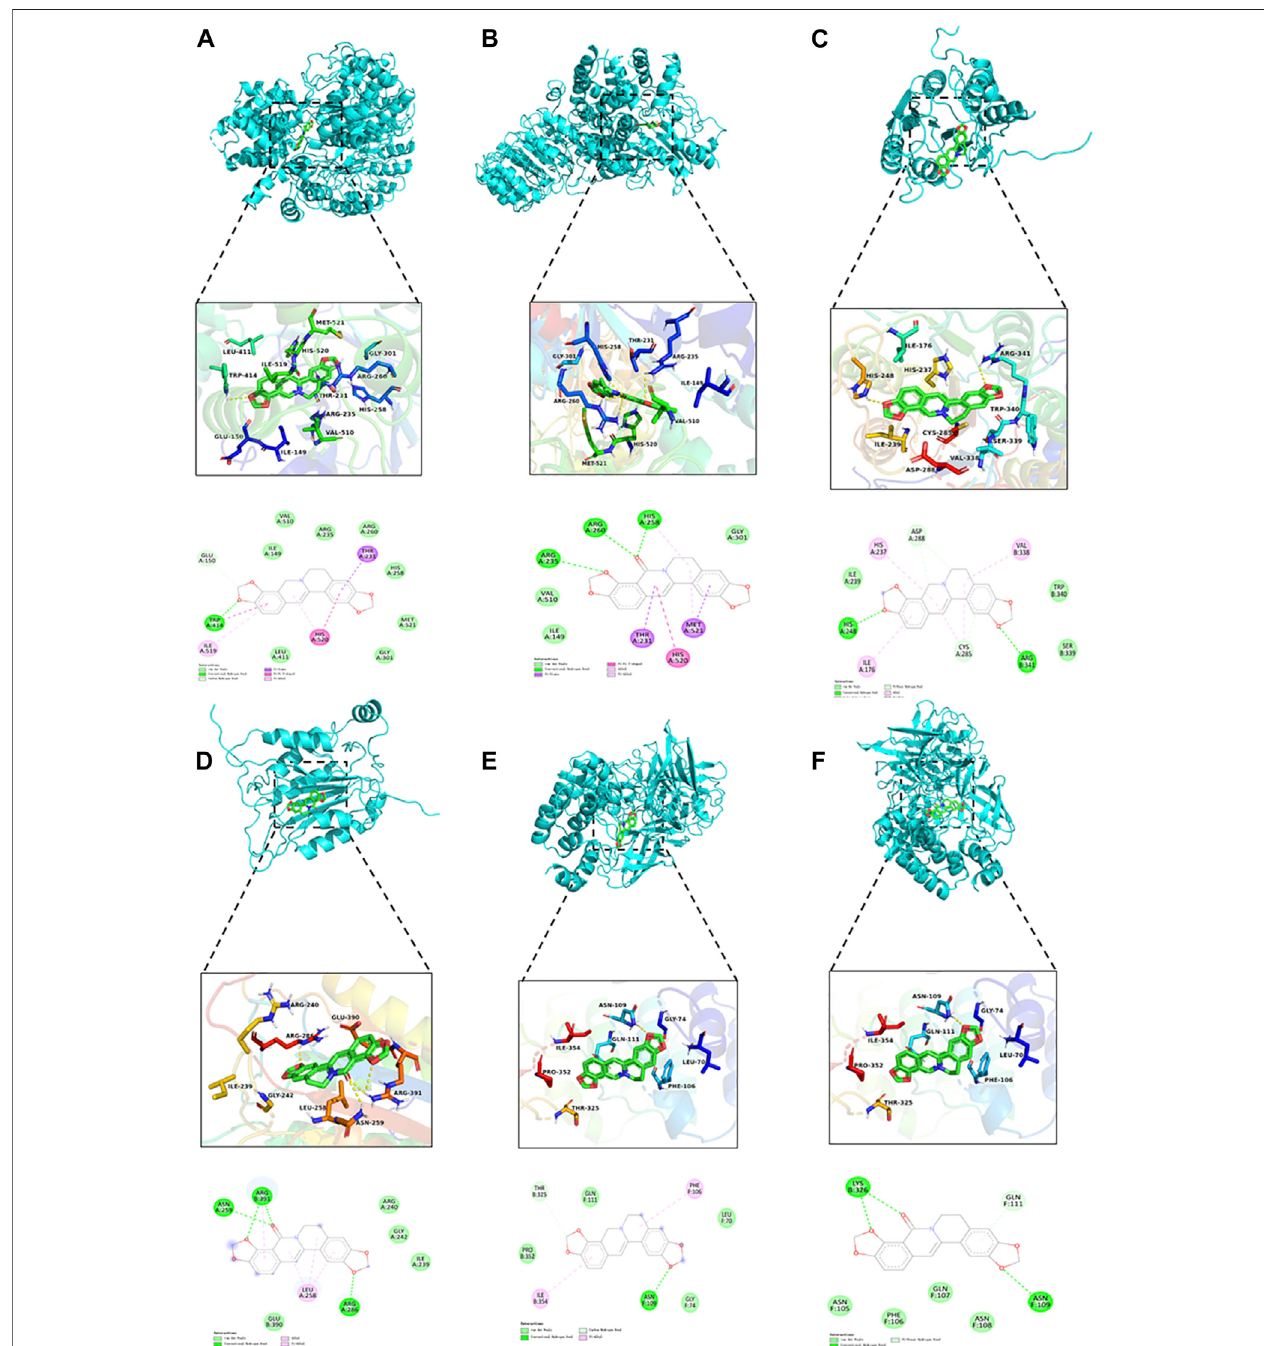
FIGURE10| MoleculardockingsimulationofCOPintotheactivesiteofNLRP3 (A) .OCOPintheactivesiteofNLRP3 (B) .COPbindingwithCaspase-1 (C) .OCOP binding with Caspase-1 (D) . COP binding with NF- κ B (E) . OCOP binding with NF- κ B (F) .